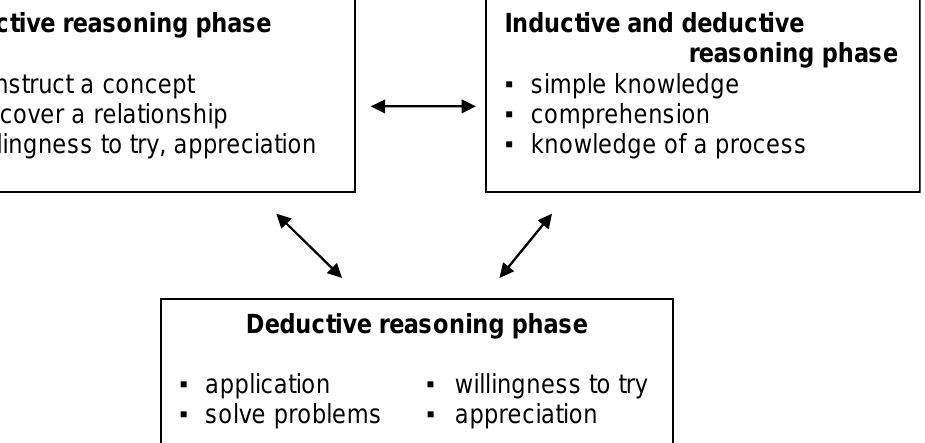
Figure 1. A guided problem-solving teaching